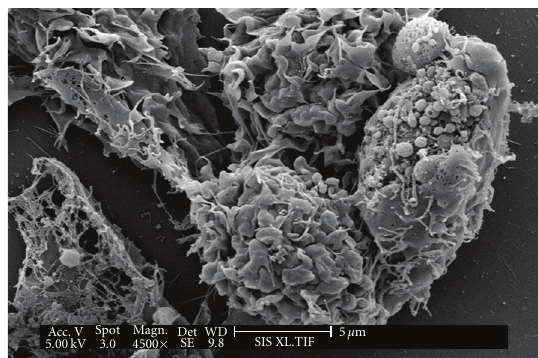
Figure 6: Scanning electron micrograph of a HeLa cell treated with extracts of Atriplex confertifolia showing the formation of apoptotic